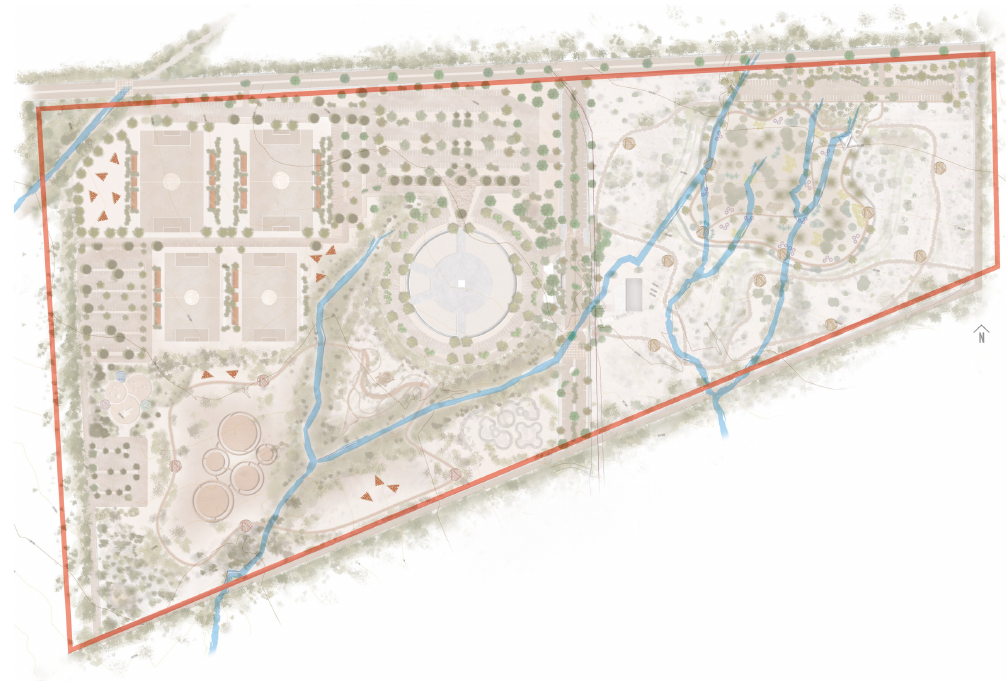
Figure 7. Final masterplan for the stormwater park in the green belt of Hermosillo, Mexico (credit: I. Pineda).